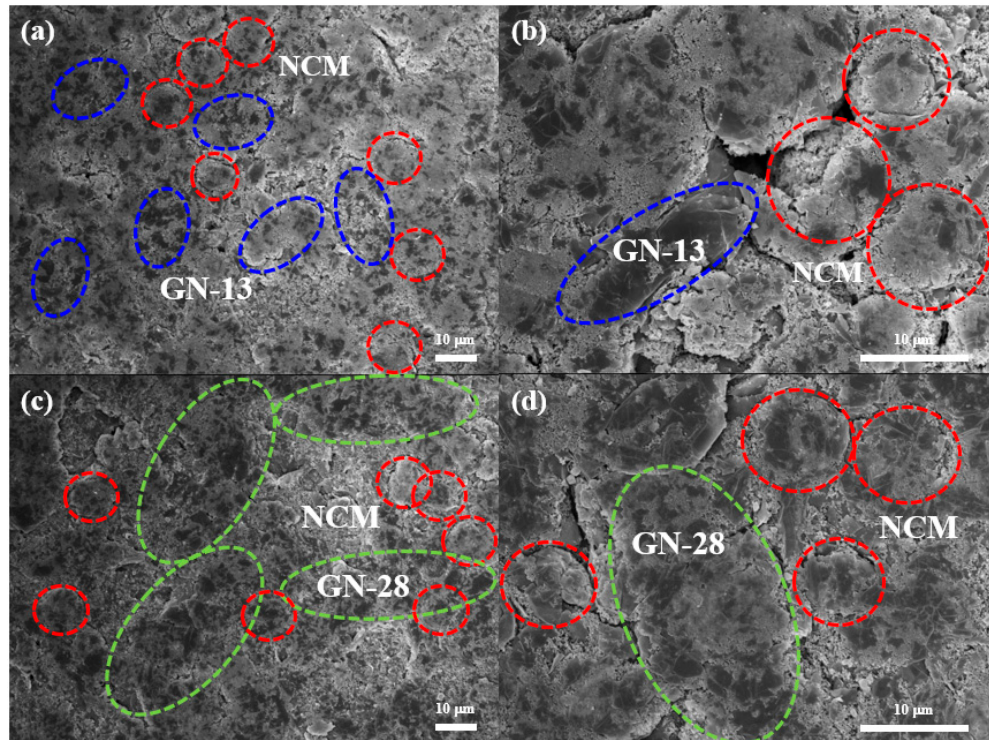
Figure 9. SEM images of fresh electrodes by using different graphene as conductive additives: ( a ) and ( b ) GN-13 electrode; ( c ) and ( d ) GN-28 electrode. The red dash-line is NCM, the blue dash-line is GN-13 and the green dash-line is GN-28.